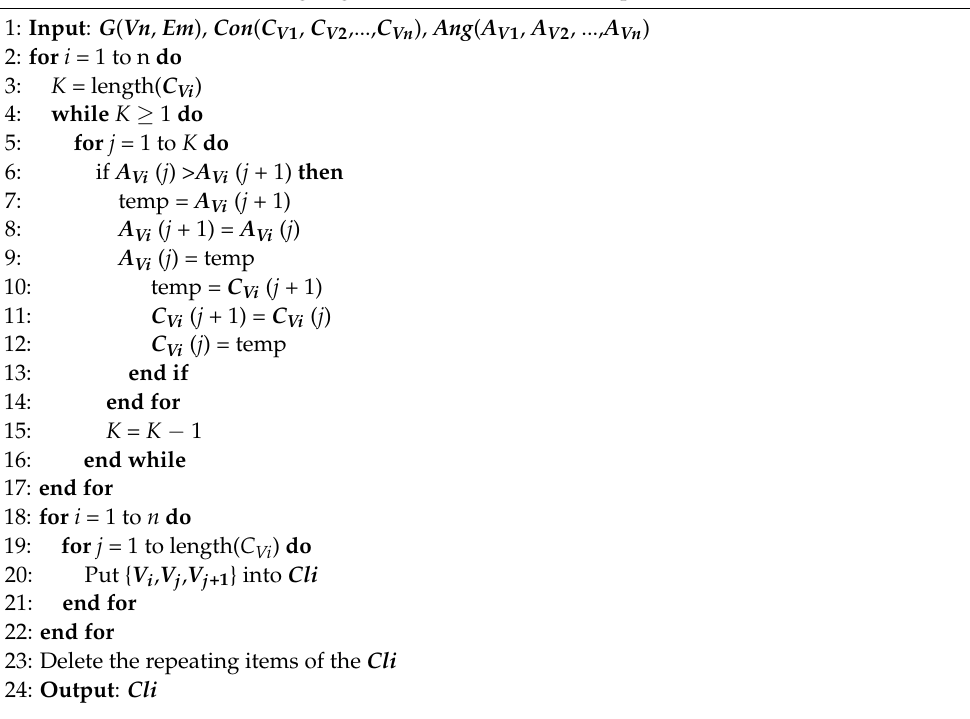
Algorithm 1 Cluster Searching Algorithm for Interference